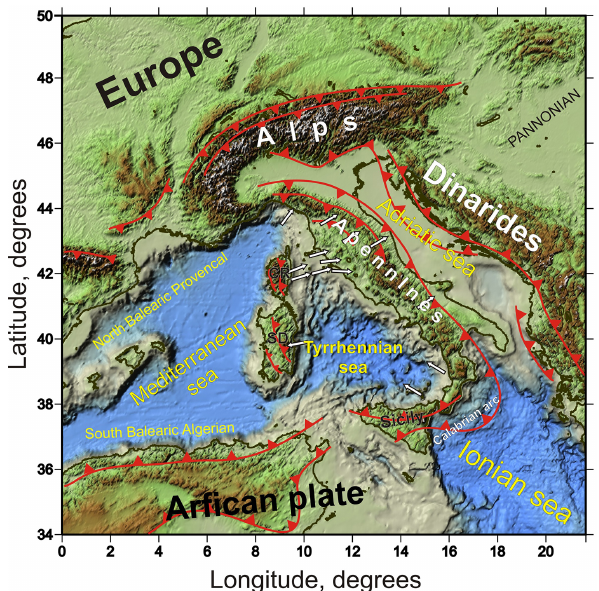
Figure 1. Topography/bathymetry map of the Tyrrhenian Sea and Calabrian regions. Major structural units and sense of transport along main thrust fronts and extensional detachments are shown ac- cording to Faccenna et al. (2004). Red lines with arrows indicate thrust and subduction